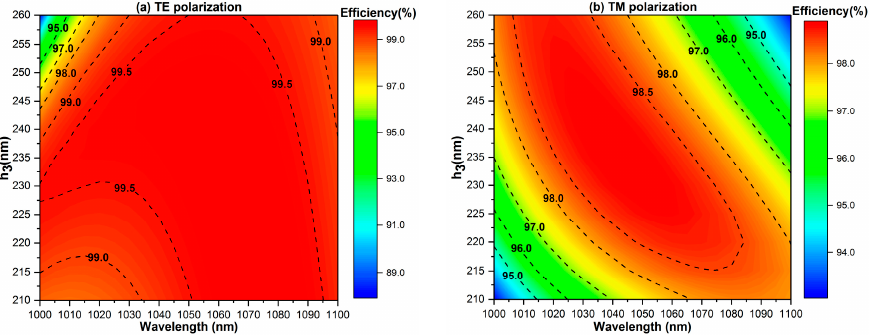
Figure 8. Tolerance analysis of the thickness of match layer. − 1st order diffraction efficiency versus incident wavelength and h 3 for ( a ) TE and ( b ) TM polarizations.